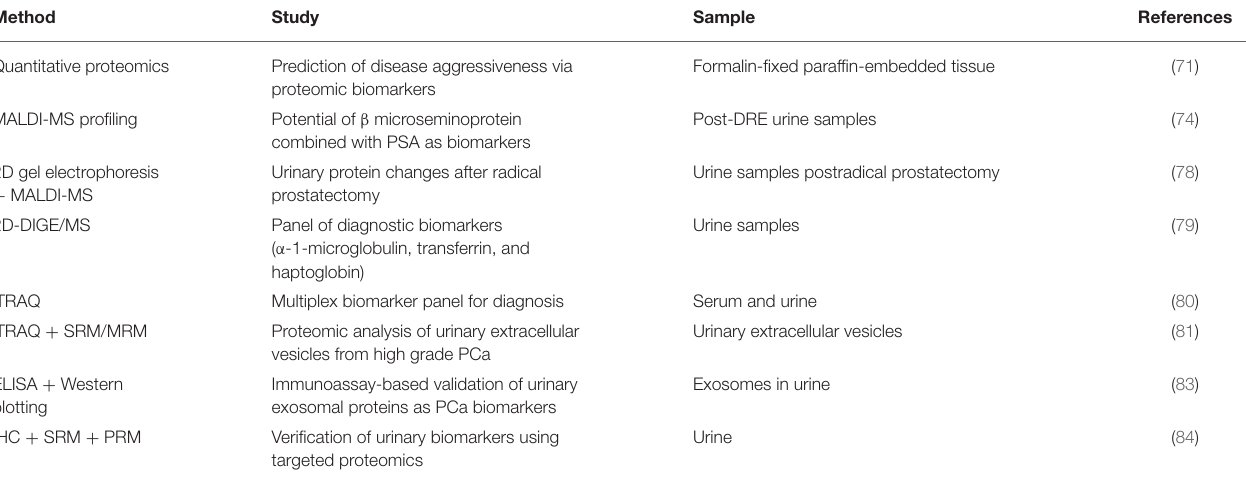
TABLE 1 | Different studies highlighting the role of proteomic techniques in precision